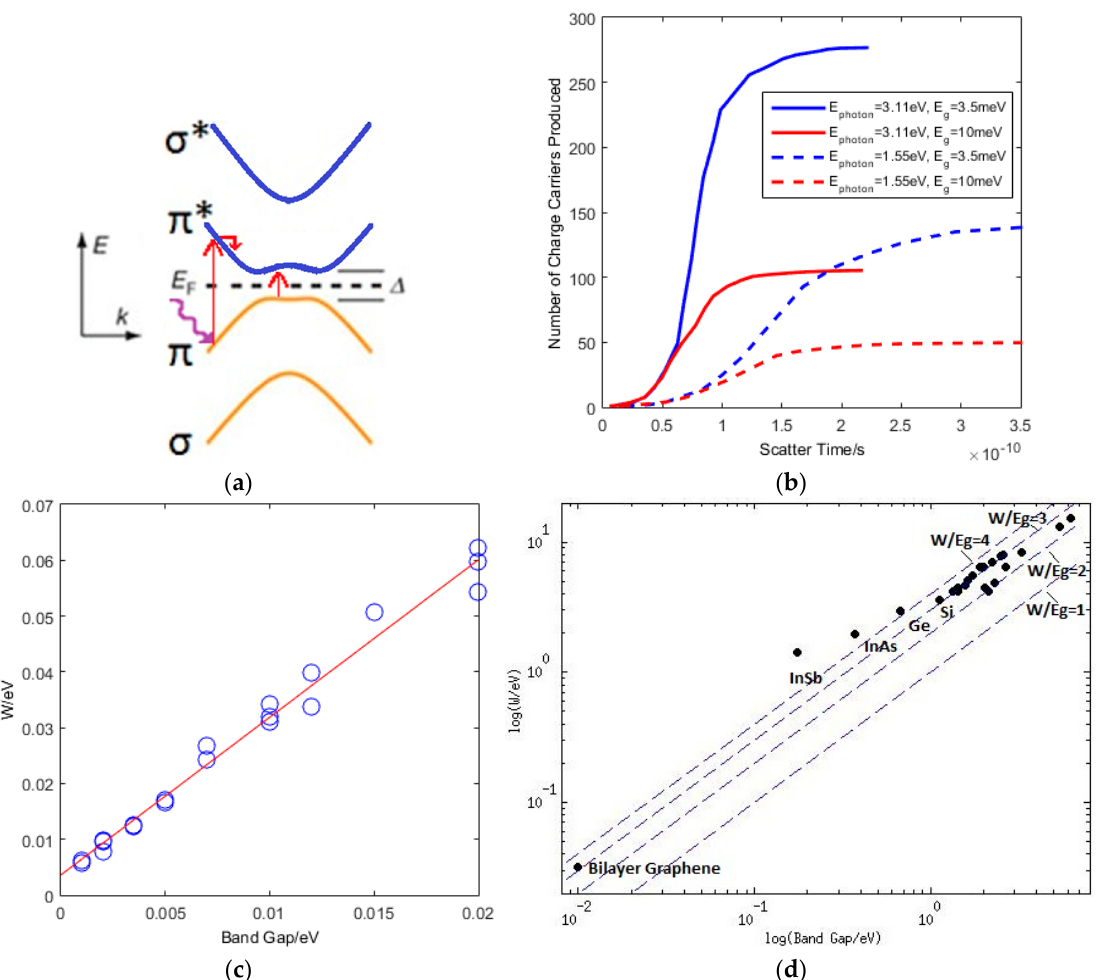
Figure 3. ( a ) Schematic to show the absorption of a photon and the excitation and subsequent relaxation the hot photoelectron; ( b ) The distribution N ( t ) at E gap = 1 meV and 3.5 meV for photons with energy 3.11 eV and 1.55 eV, and with µ = 100; ( c ) Electron-hole pair creation energy as a function of band gap with µ = 100. The circles show simulation results, and the red line is best fit straight line; ( d ) Comparison of W vs. band gap for bilayer graphene with other semiconductors.